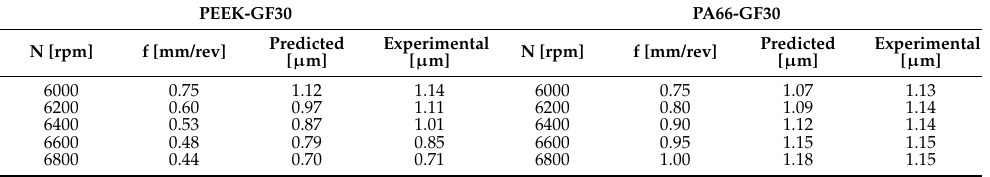
Table 9. Validation of results for average roughness,